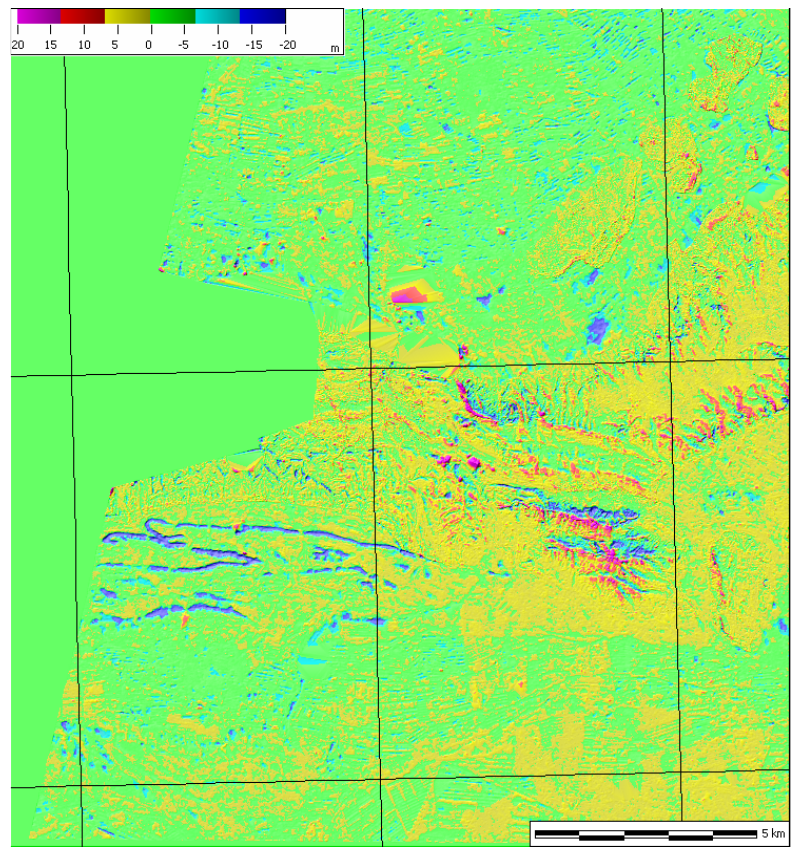
Figure 2. Residuals for the 10 m resolution DSM generated over Salon de Provence (France).